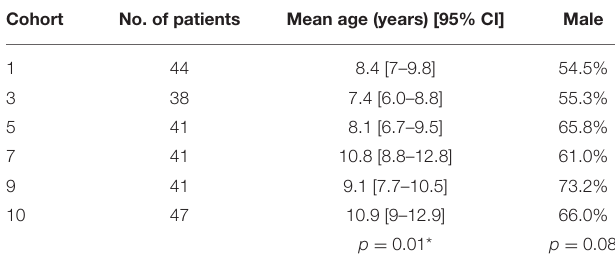
TABLE 1 | Demographic information for selected